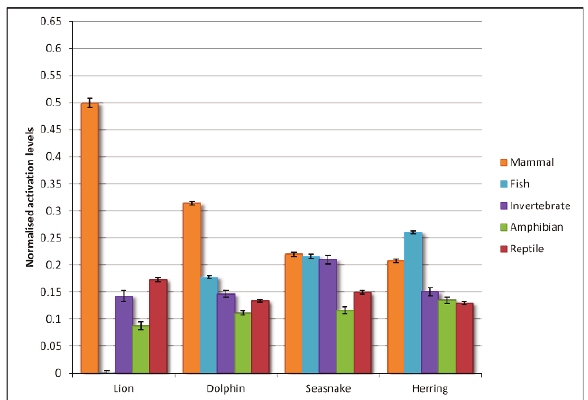
Figure 6. DAIM model classification results for four animals. The same five categories are used as in Figure 5. The results show the mean of ten randomly ordered datasets (see main text for details): the error bars show 95% confidence intervals. As for the CS model, all animals are classified correctly except